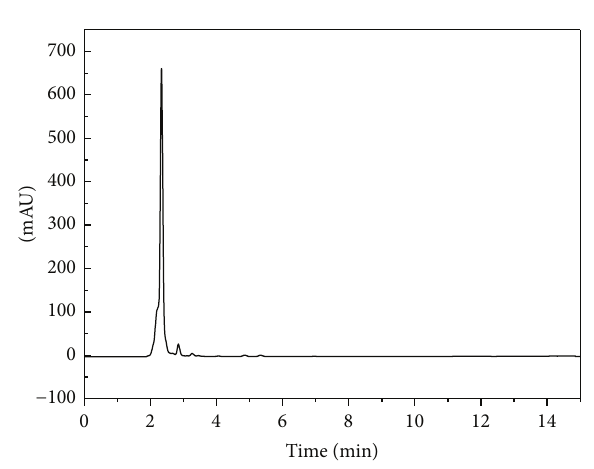
Figure 10: HPLC of lung